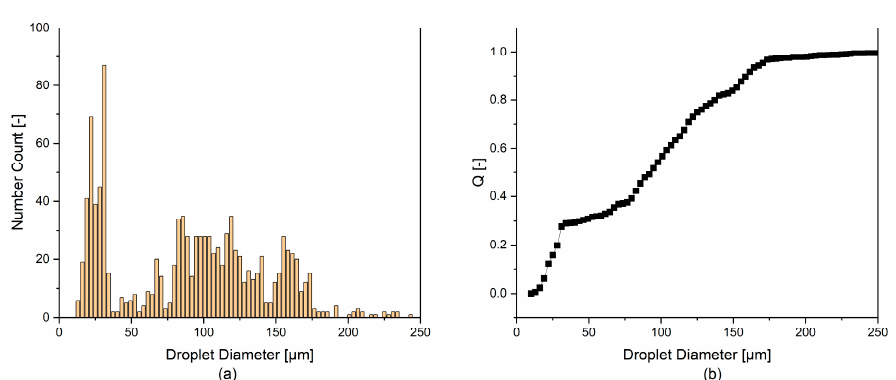
Figure 25. Histogram of Sauter diameters ( a ) and cumulative distribution ( b ) of all images from the SOPAT probe of the biomass experiment.